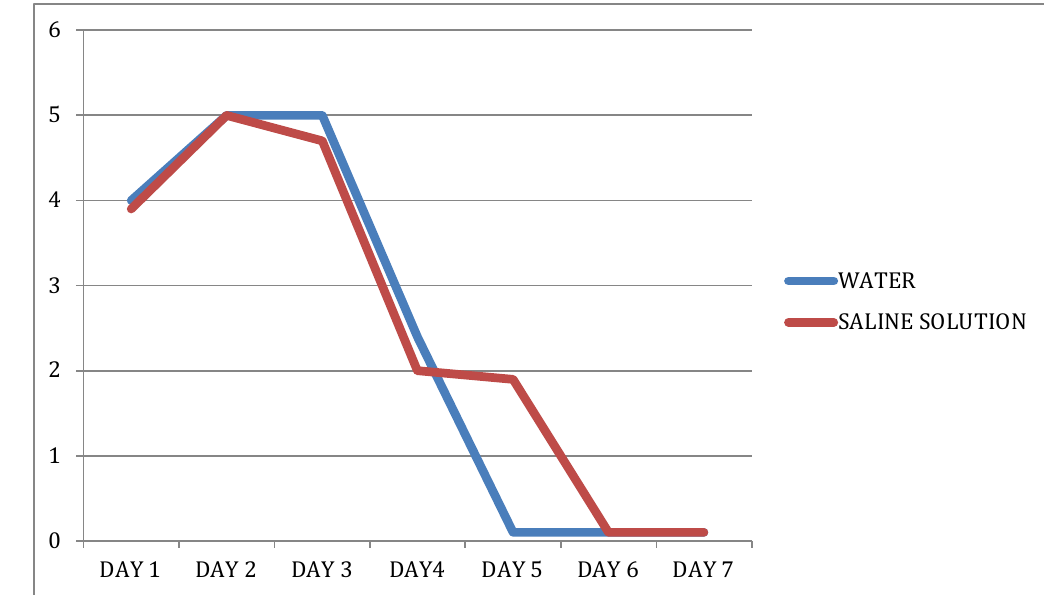
Figure 1. Vas values during time.